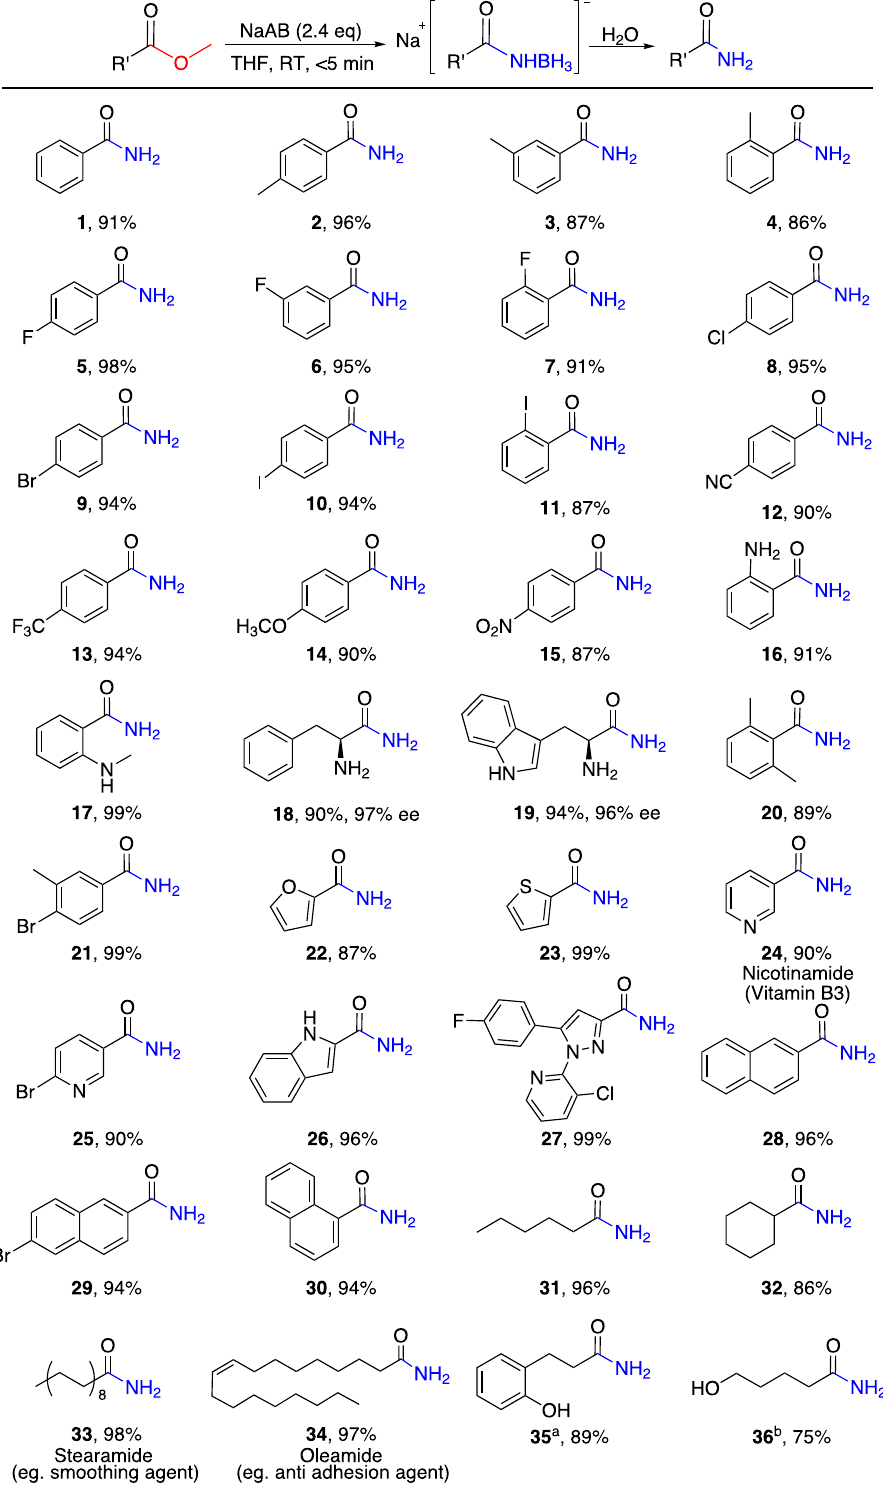
Fig. 2 Reactions of NaAB with various esters in THF. Reaction conditions: ester (0.5 mmol), NaAB (2.4 equiv), THF (5 mL), room temperature for 5 min and then hydrolysis. a, b The substrate esters are dihydrocoumarin and valerolactone, NH 3 BH 3 and Na[PhC(O)NHBH 3 ], respectively, and both quartet NH 3 BH 3 and Na[PhC(O)NHBH 3 ]. The Na[PhC(O)NHBH 3 ] signals display as a singlet at the corresponding chemical shift in intermediate is isolated and characterized by NMR and MS 11 B{ 1 H} spectrum (Supplementary Fig. 9b). The 1 H and 1 H{ 11 B} (Supplementary Figs. 2-6), which converts into the corresponding amides after hydrolysis. A singlet signal appears at δ 3.29 ppm is spectra (Supplementary Figs. 10-11) con fi rm the formation of